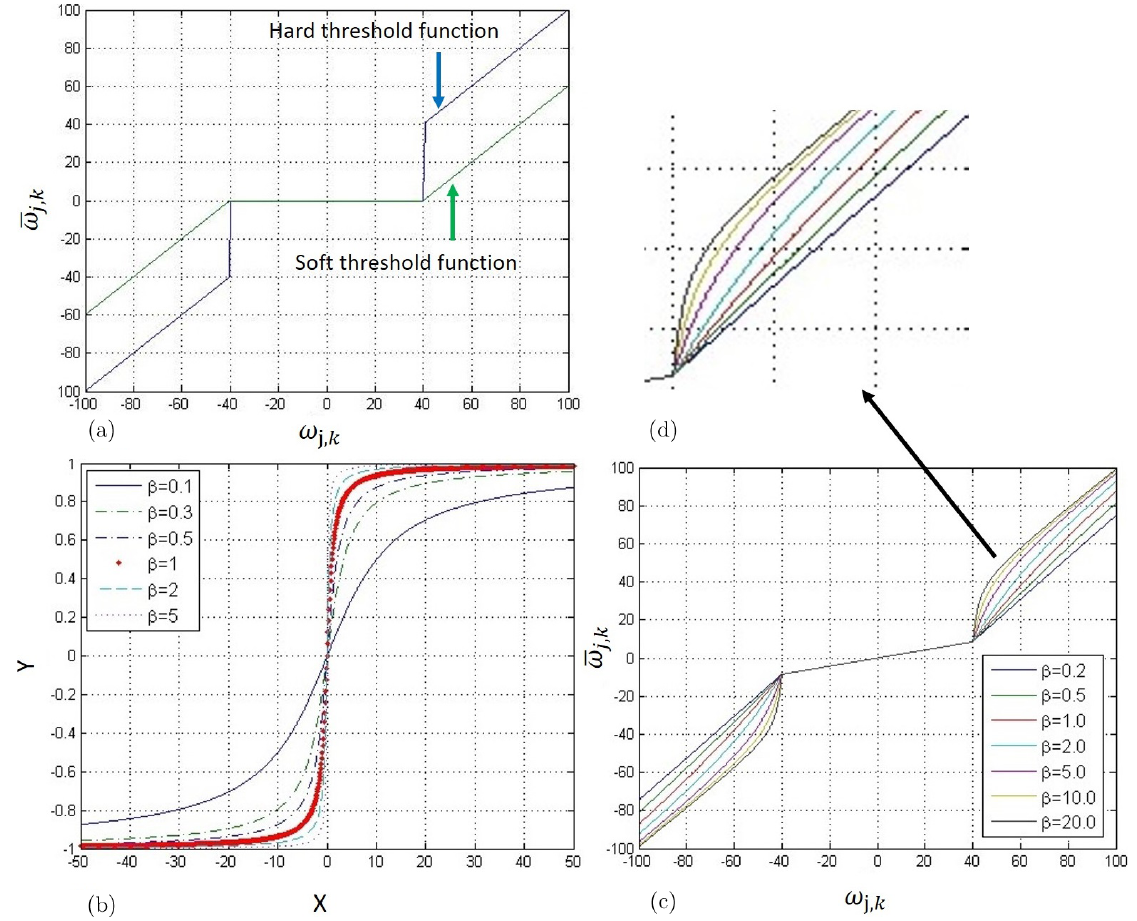
Fig. 1. Diagram of threshold functions. (a) Two conventional threshold functions: Hard (blue curve) and soft (green curve); (b) modi¯ed curvature function; (c) the improved threshold function (when (cid:2) is varied from 0.2 to 20); (d) zooming up of the area pointed by black arrow in Fig.